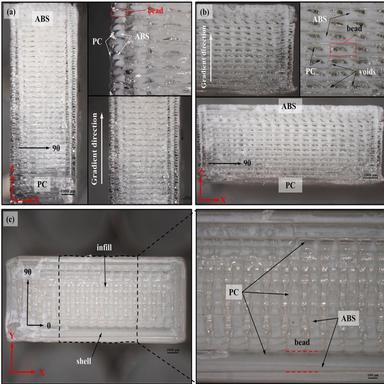
Morphology of cross-sections of fractured specimens after tensile testing (a) specimen printed on YZ plane (b) specimen printed on XY plane (c) specimen printed on XZ plane.